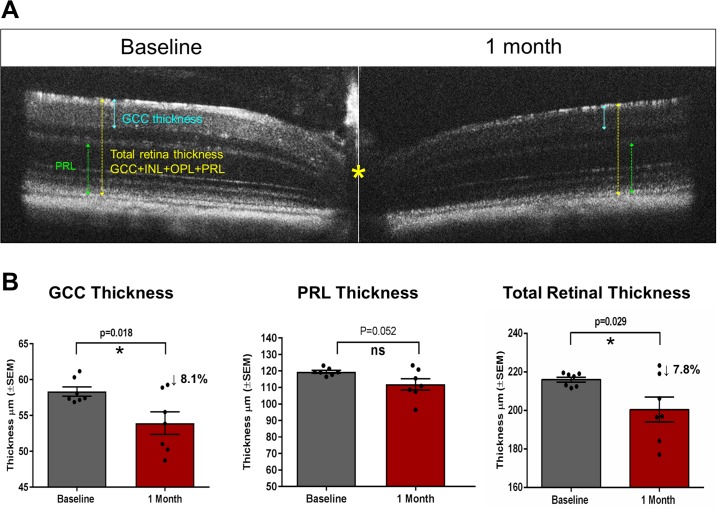
Ocular hypertension caused significant thinning of the inner retina.(A) Representative retina images obtained from optical coherence tomography (OCT) at baseline (left) and 1 month post-OHT induction by HAMA xl (right). Asterisk marks the position of the optic nerve head (ONH). (B) Analyses of the thicknesses of the ganglion cell complex (GCC), photoreceptor layer (PRL), and the total retina. GCC = NFL+ GCL+ IPL, as indicated by the blue solid line; PRL = ONL + IS + OS (from outer boundary of OPL to RPE), as indicated by the dotted green line; total neuroretina thickness was measured from NFL to RPE layer as indicated by the yellow dotted line. * P<0.05 by Student’s paired t-test.